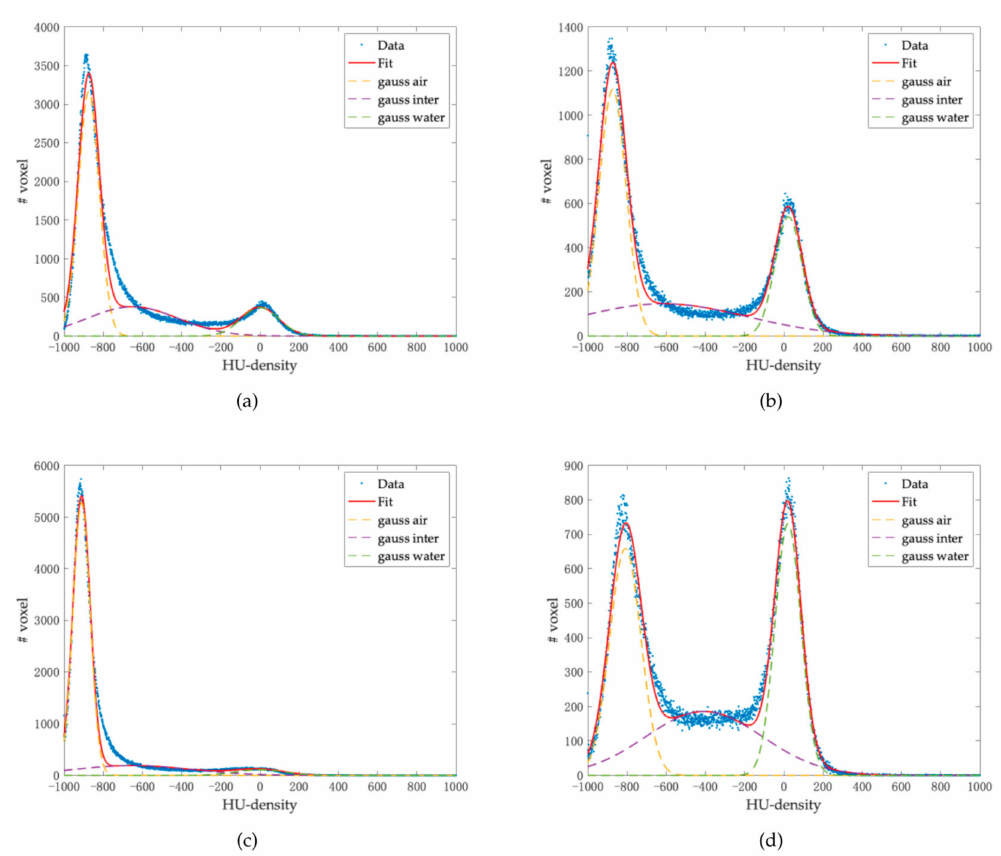
Figure 2. ( a – d ) Examples of HU-density histogram fit. Each plot shows the overall fit and the three Gaussians that compose